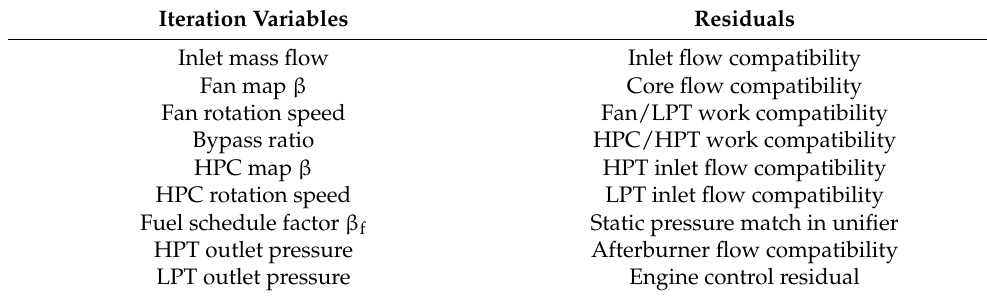
Table 1. Iteration variables and residuals of the GESTPAN calculations.